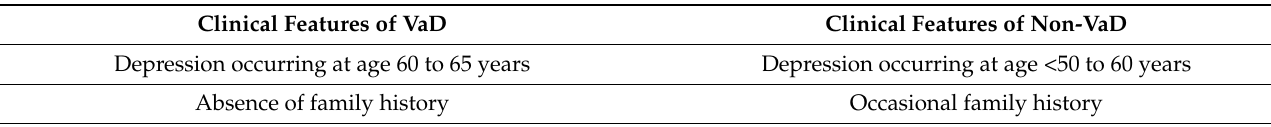
Table 1. Clinical features of vascular depression (VaD) and non-VaD. Modified from